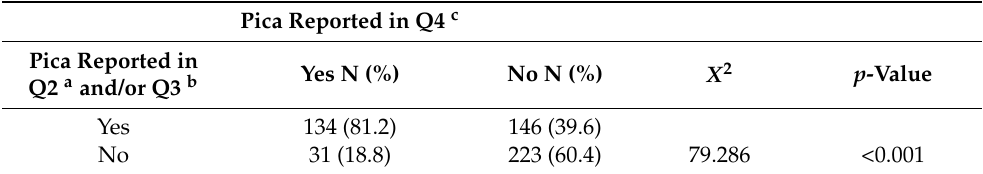
Table 3. Results of a chi square test for association between pica reported in early timepoints (Questionnaire 2 and/or 3) and Questionnaire 4 (n =